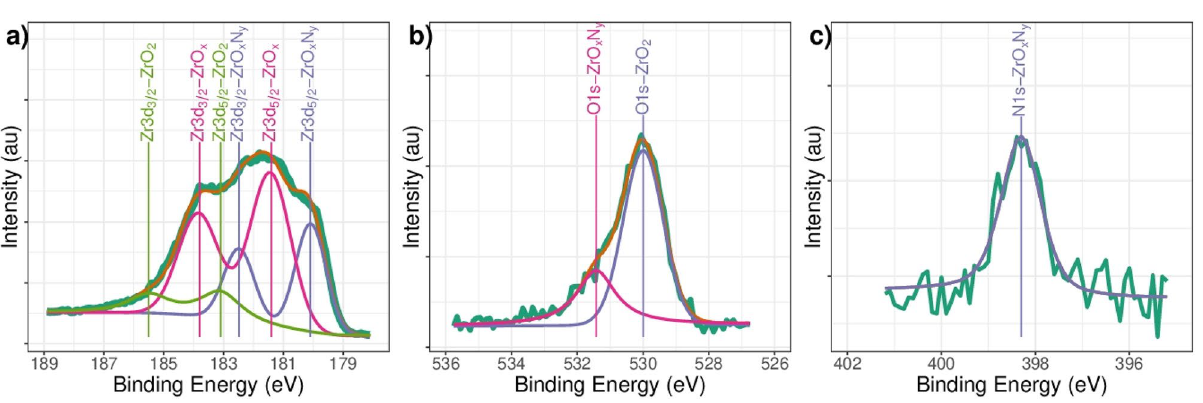
Figure 4. High-resolution XPS spectral analysis for the ( a ) Zr3d, ( b ) O1s and ( c ) N1s signals in ZrN-ZrO x N y coatings after 15 min of etching.